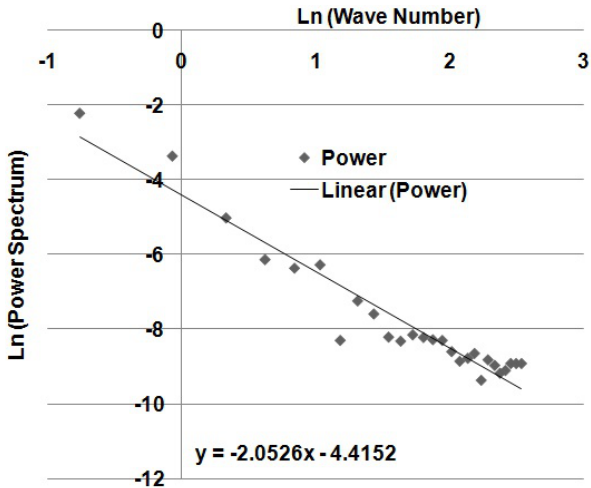
Fig. 3. Log-log plot of power spectrum of heat production data vs. wave number for the Vredefort granitic basement (Kaapvaal cra- ton), South Africa. Best linear fit gives scaling exponent of 2.0, which conforms to fractal behavior in the data set. Strong correla- tion can be seen among data points.